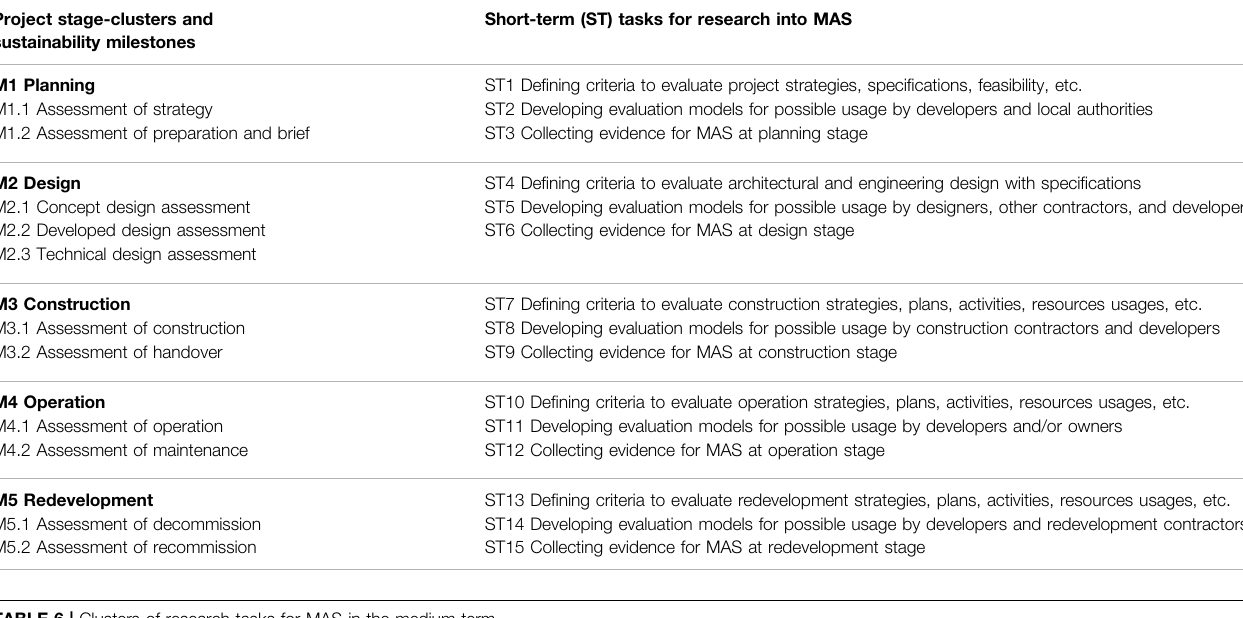
TABLE 5 | Clusters of research tasks for MAS in the short term.